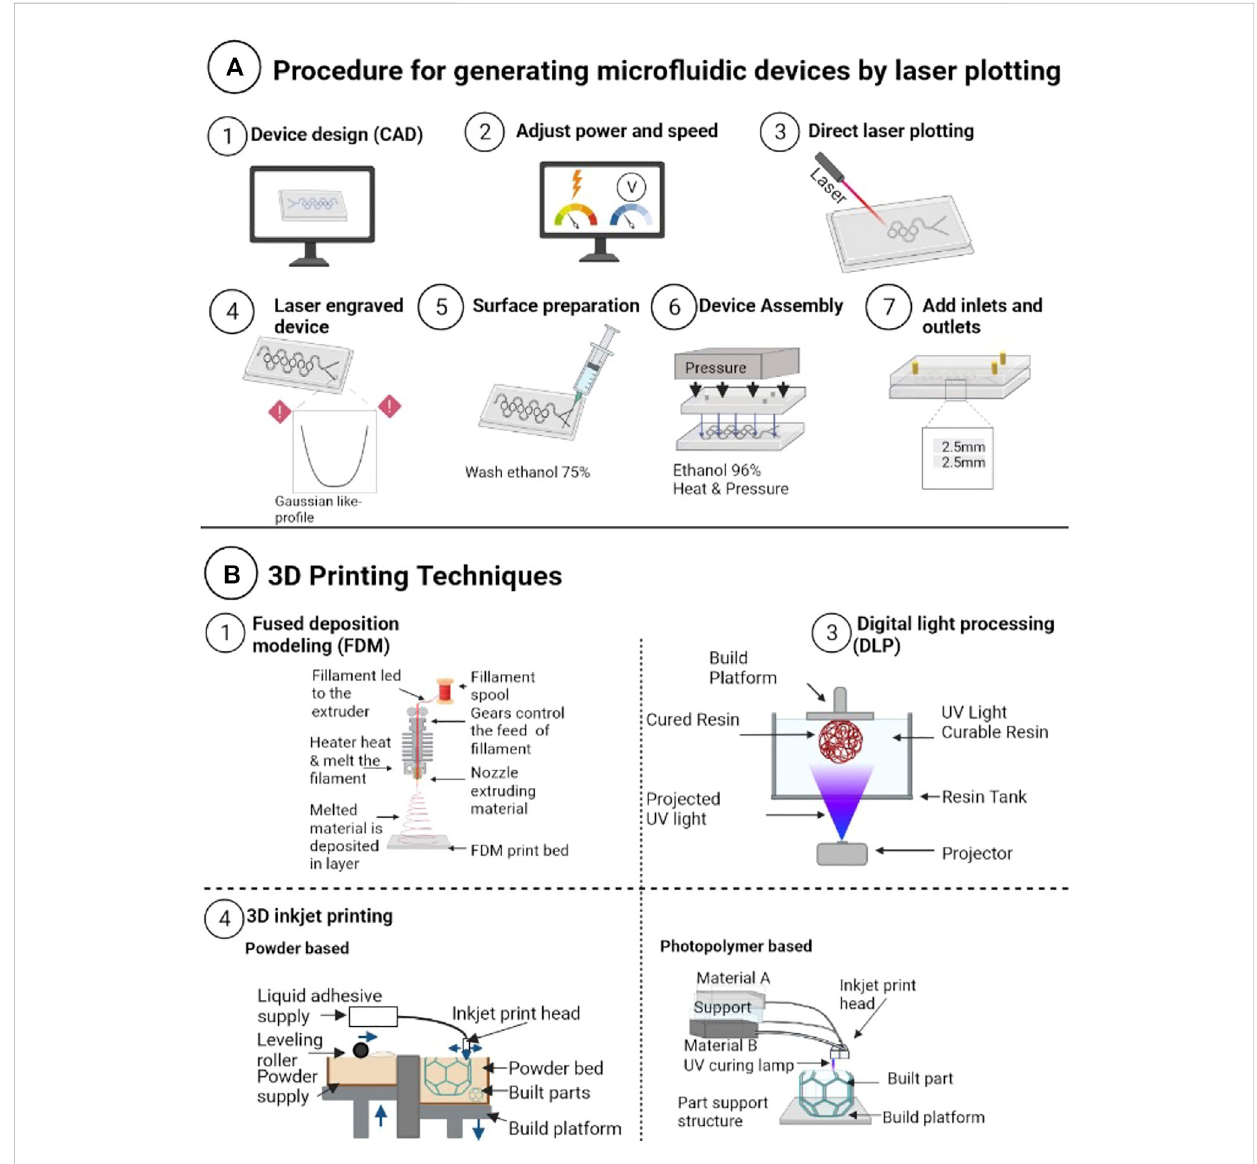
FIGURE 2 (A) : 3D printing techniques adapted from Prabhakar et al. (2021), and Padash et al. (2020), including: 1) Fused Deposition Modeling (FDM), which involves heating and extruding material through a nozzle to create layers of the micro fl uidic device. 2) Stereolithography (SLA) uses a UV laser to solidify resin and generate the device. 3)Digital Light Processing (DLP), which selectively shines light onto the resin using a digital projector. (B) : Laser engraving process for creating a micro fl uidic device, which includes the following steps: 1) CAD software is used to design the device. 2) Adjust the laser ’ s speed and power to achieve the desired microchannel depth. 3) Using laser engraving, which has thedisadvantage of producing aGaussian pro fi le.4) To remove residues,wash thesurfacewith 75% ethanol. 5)Using 96%ethanol and heat,jointhe device ’ slid to thebottom layer.6) Gluing thedevice ’ sinputs and